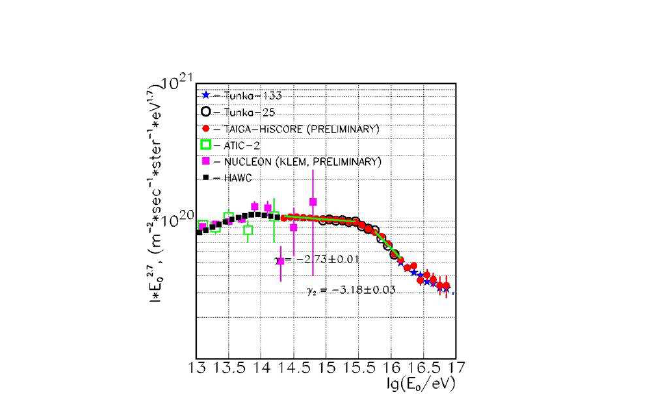
Figure 2. The energy spectrum of primary cosmic rays from the data of the TAIGA-HiSCORE array in comparison with other